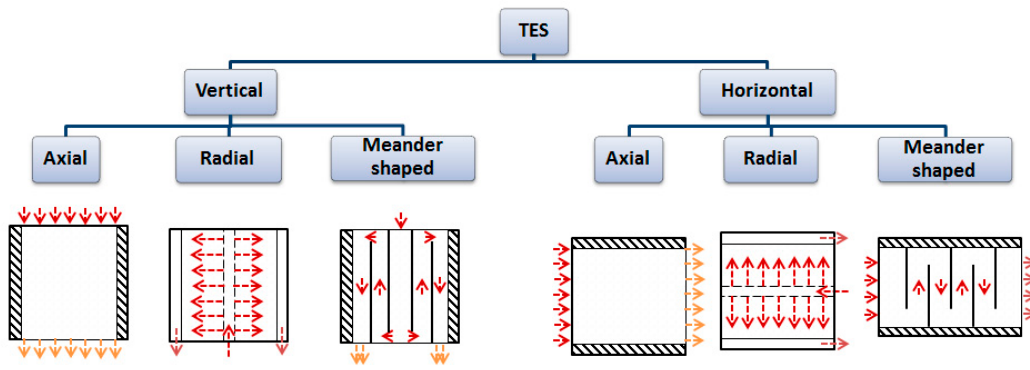
Figure 3. Matrix of variants for TES.